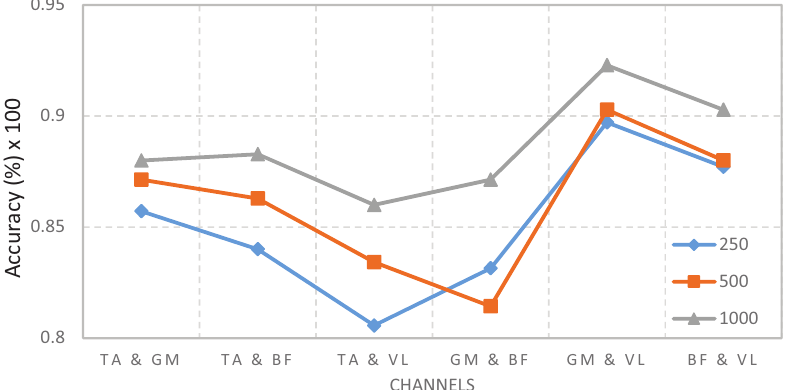
Figure 3. Classification accuracy with two channels.